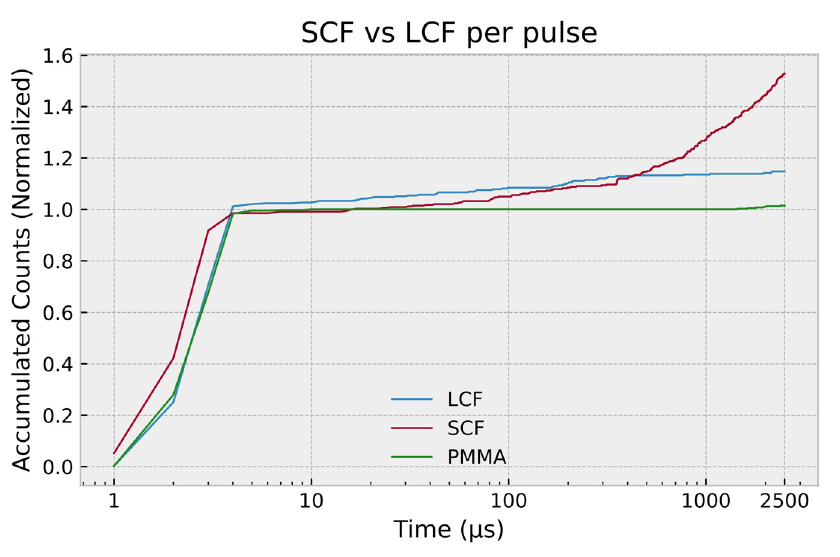
Figure 10. Normalized accumulated counts (gate time of 1 μ s) with respect to time. Values are normalized to the total response of the PMMA carrier fiber during radiation exposure ( ≈ 4 μ s).